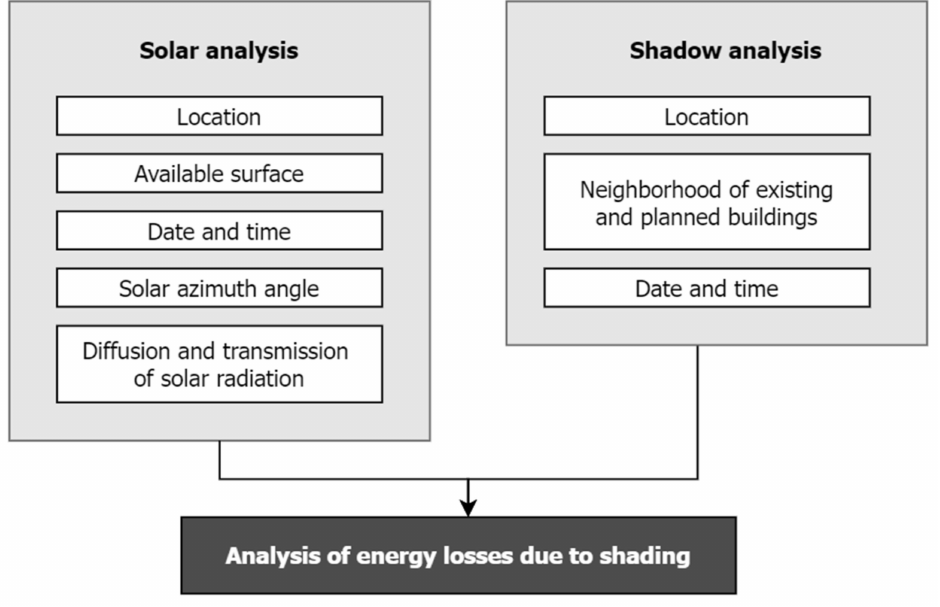
Figure 8. Factors included in solar and shading